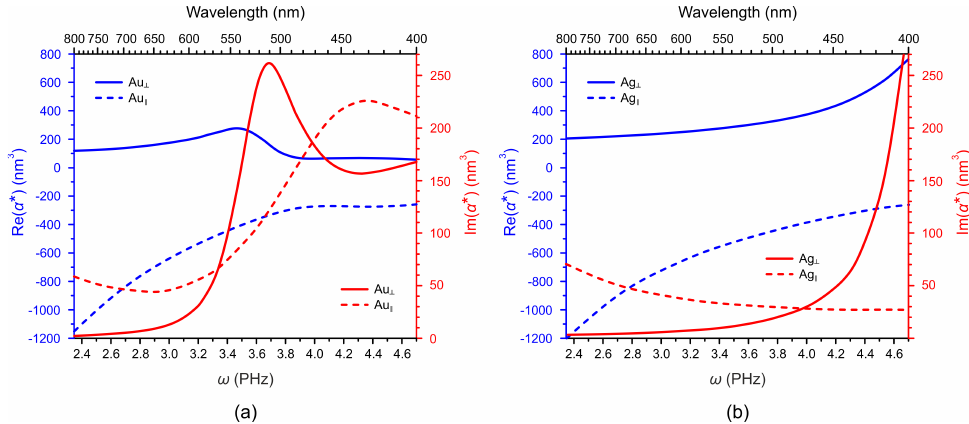
Figure 1. Real and imaginary parts of the transverse and longitudinal components of the effective high-frequency polarizability of gold ( a ) and silver ( b ) rod-like NPs embedded into the 5CB nematic host phase. Rod-like NP is an ellipsoid of revolution with the principal diameters 35 nm and 5 nm.